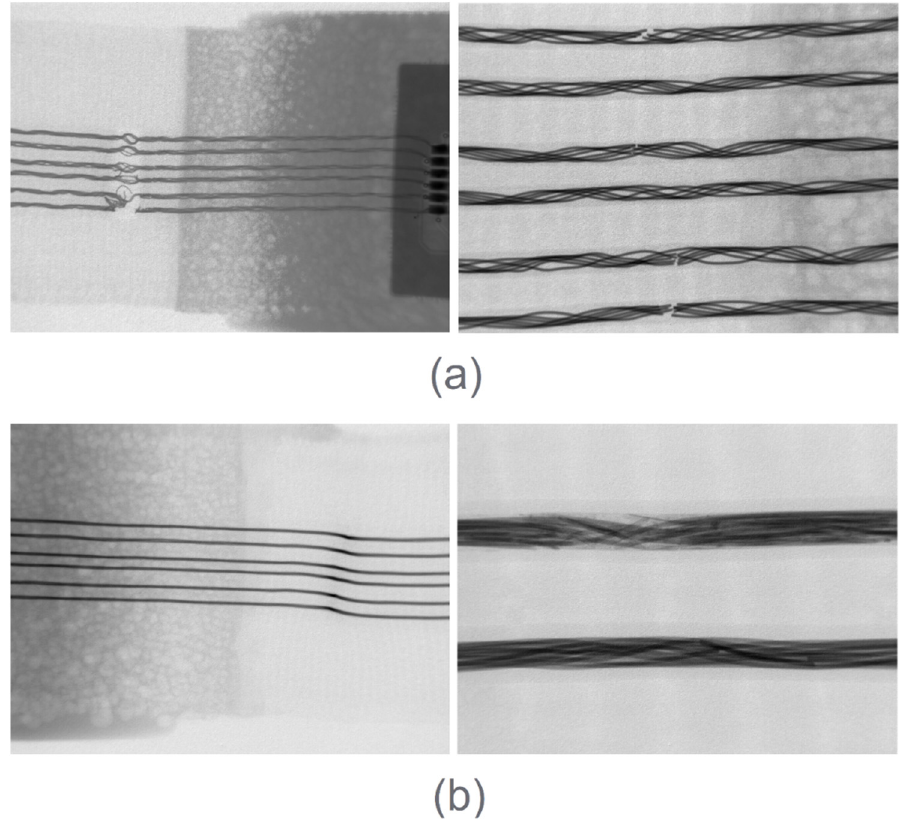
Figure 6. X-ray inspection photos after bending tests. ( a ) Yarn 1 after bending tests. ( b ) Yarn 2 after bending tests.